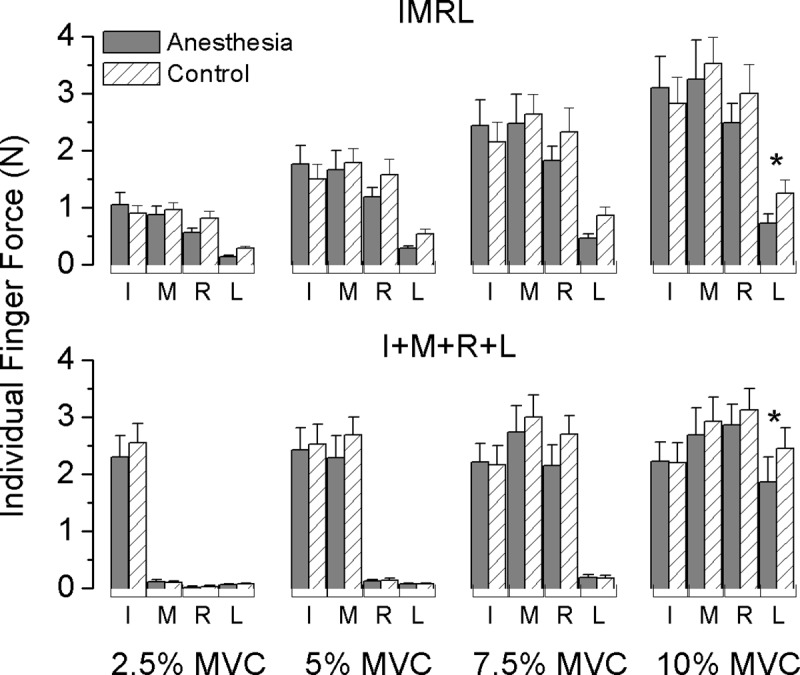
Averaged individual finger force in synergy tasks (mean ± SE).Absolute forces (in Newton) contributed by each individual finger as a function of task-required force levels (ranged from 2.5% - 10% MVC) are plotted for IMRL synergy task (top panel) and I+M+R+L synergy task (bottom panel) respectively. Plotted forces are firstly averaged over each force level per trial, task and subject and further averaged across subjects in Anesthesia and control session separately. Asterisk indicates an interesting significant difference between sessions at a non-local digit L (P < 0.05).